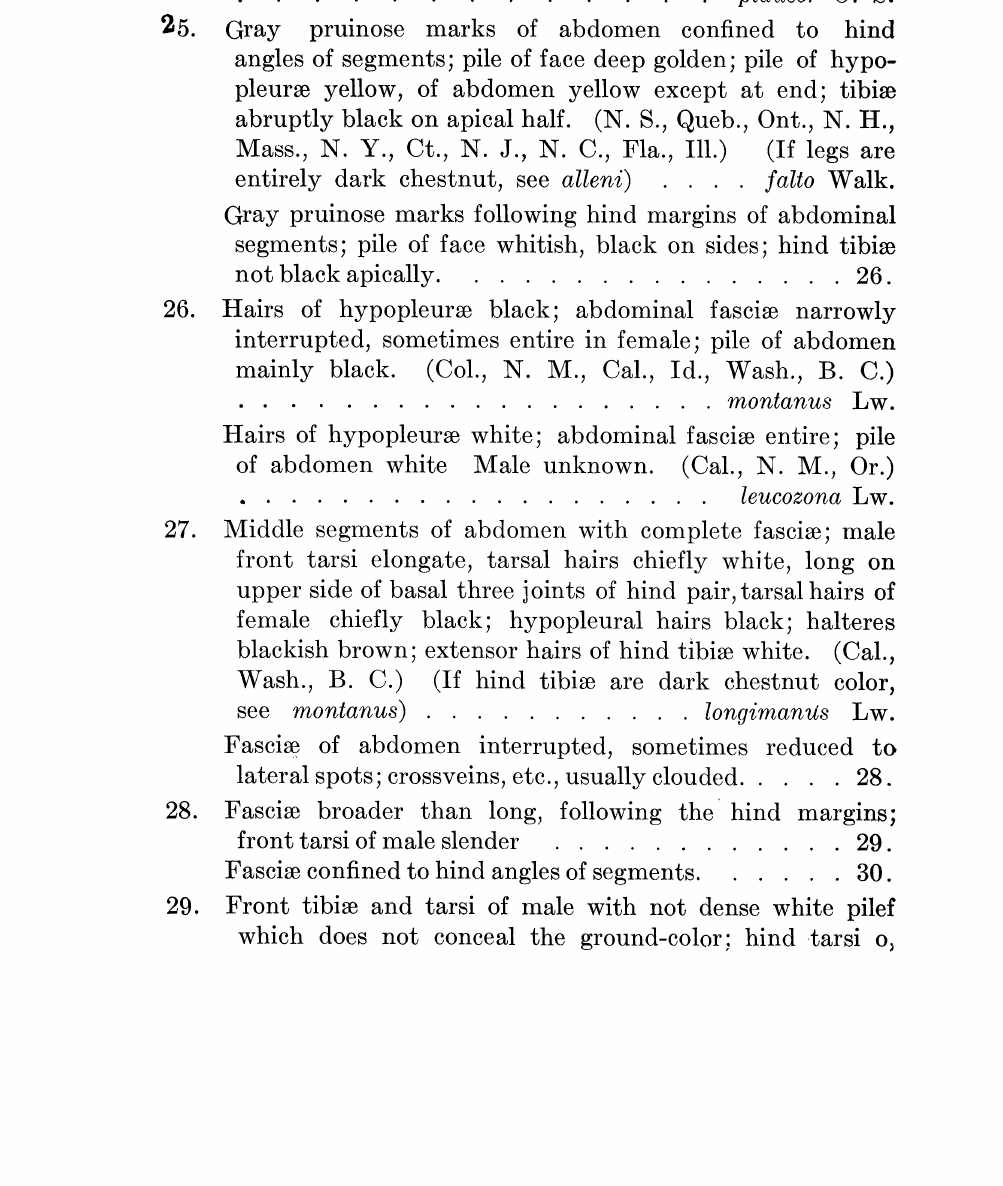
25. Gray pruinose marks of abdomen confined to hind angles of segments; pile of face deep golden; pile of hypo- pleurm yellow, of abdomen yellow except at end; tibim abruptly black on apical half. (N. S., Queb., Ont., N. H., entirely dark chestnut, see alleni) falto Walk. Gray pruinose marks following hind margins of abdominal segments; pile of face whitish, black on sides; hind tibiae not black apically mainly